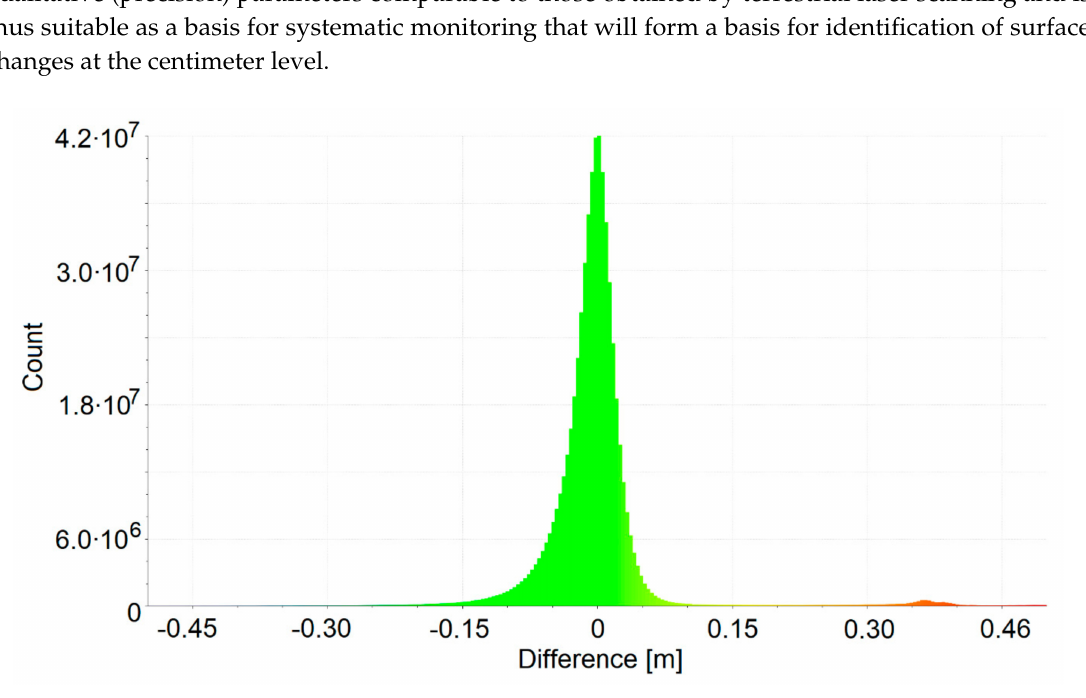
Figure 13. A histogram characterizing the distribution of the data di ff erences in the unfiltered cloud showing a red group of outliers caused by low